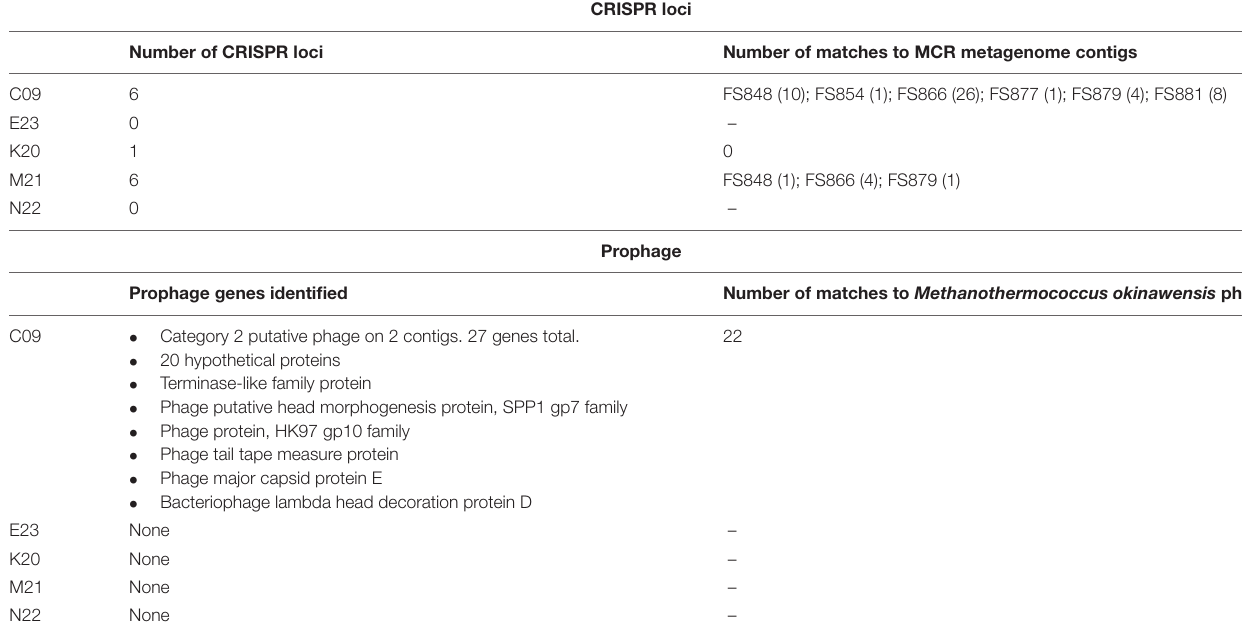
TABLE 2 | Prophage and CRISPR loci in Methanothermococcus SAGs from the Mid-Cayman Rise (MCR).